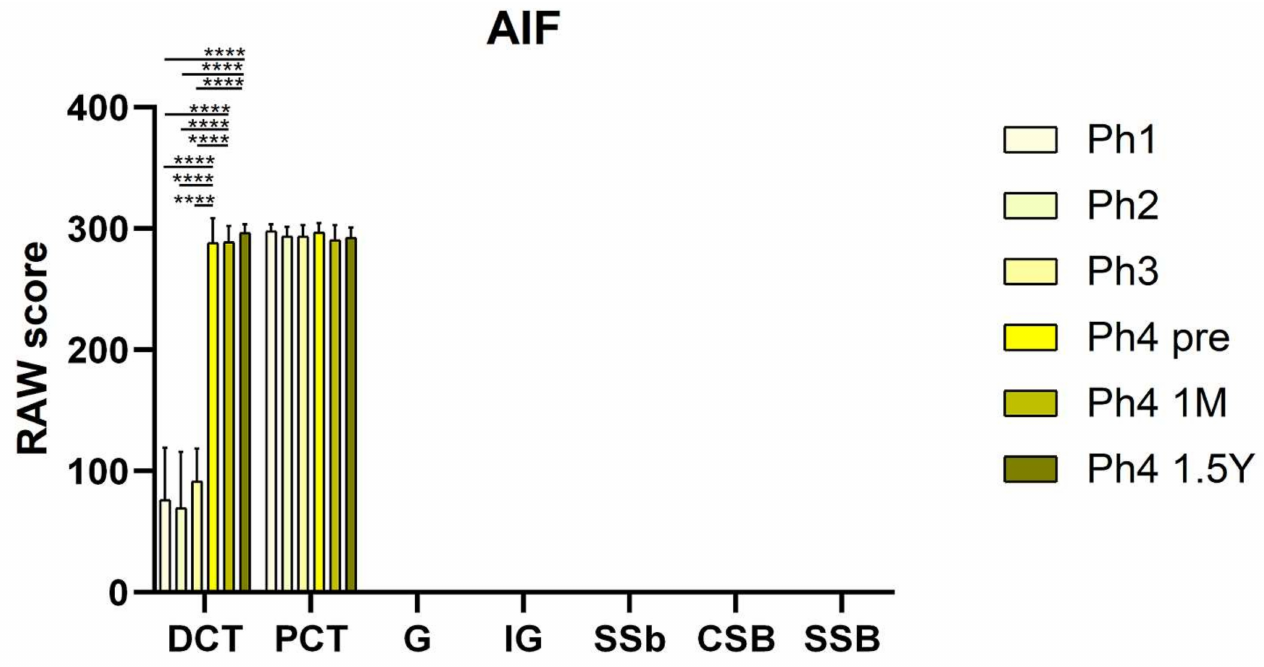
Figure 5. RAW scores of AIF in the cortical nephron structures of human fetal and postnatal kidneys. Fully differentiated glomeruli (G), proximal convoluted tubules (PCT), distal convoluted tubules (DCT), immature glomeruli (IG),